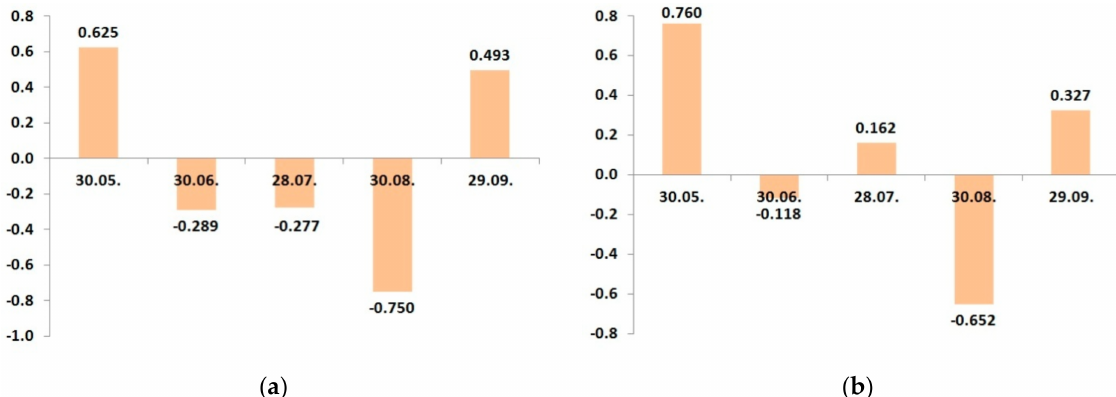
Figure 2. Dynamic changes of correlation coefficients between the potassium leaf status and yield cv. ‘Zhigulevskoye’ in growing seasons: ( a ) 2016; ( b ) 2017